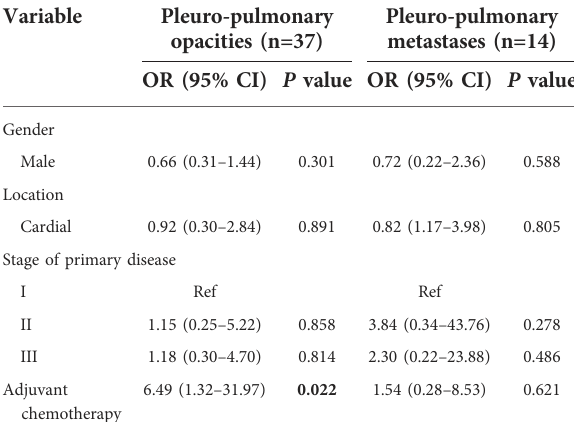
TABLE 3 Multivariate analysis for predictors of developing pleuro- pulmonary opacities and metastases among patients with gastric adenocarcinoma treated with curative intent.